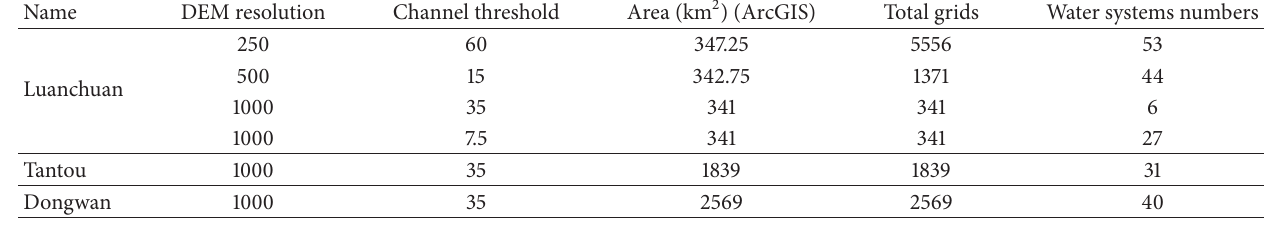
Table 1: Information and statistics of the nested catchments.